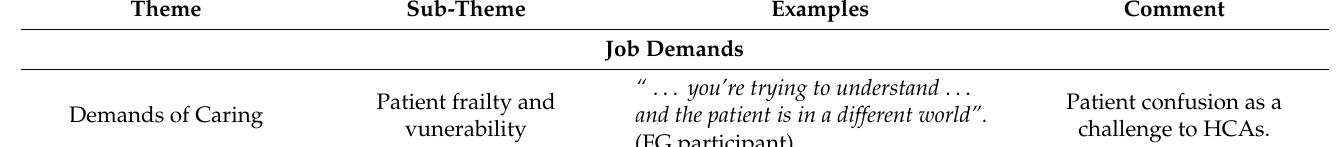
Table 1. Supplementary quotes from HCAs illustrative of examples of sub-themes arising from individual and focus group (FG) interviews. See also the